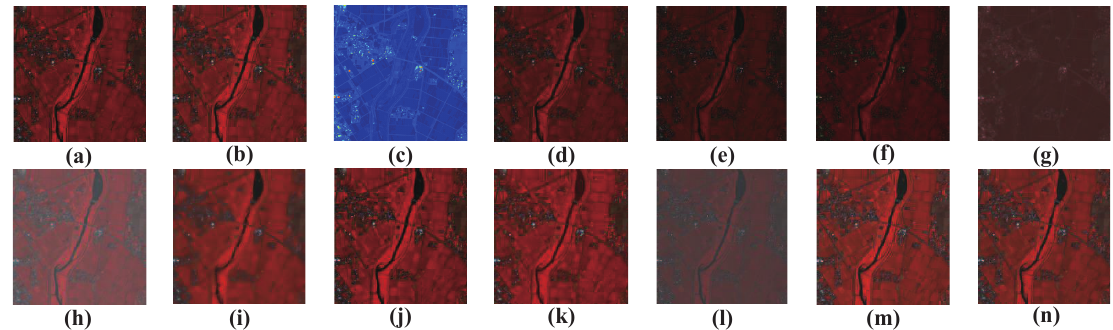
Figure 11. Visual results obtained by different methods on the Chikusei data set: ( a ) ground truth, ( b ) up-sampled HSI, ( c ) PAN, ( d ) SFIM, ( e ) MTF-GLP, ( f ) MTF-GLP-HPM, ( g ) GS, ( h ) GSA, ( i ) GFPCA, ( j ) CNMF, ( k ) Lanaras’s, ( l ) FUSE, ( m ) HySure, ( n ) SCAAE. Note that the false color image is chosen for clear visualization (red: 20, green: 40, and blue: 80).